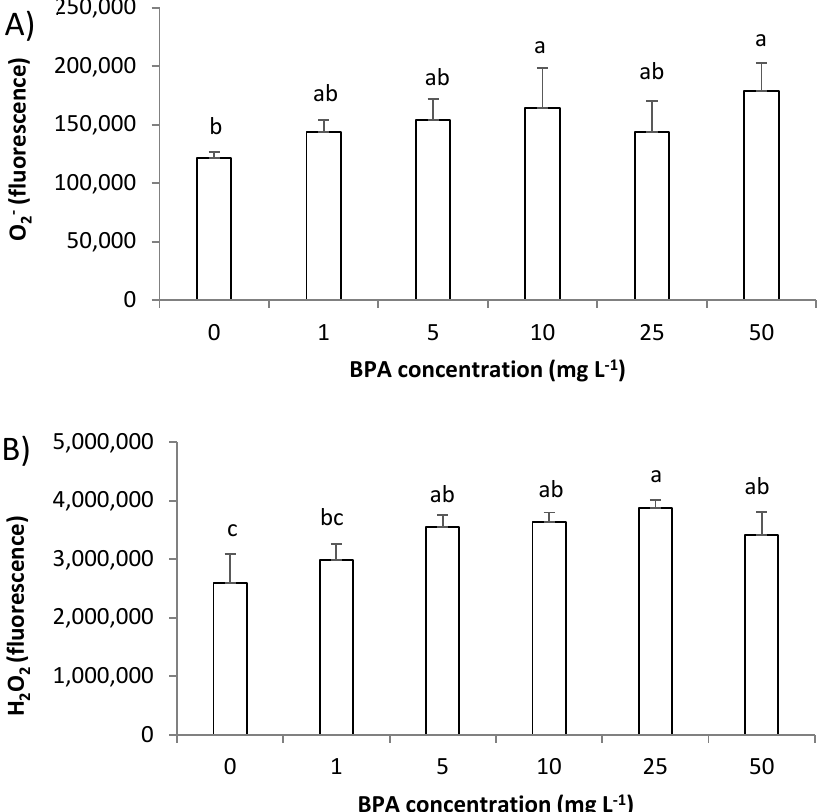
Figure 4. Level of reactive oxygen species (ROS) in root cells of Allium cepa exposed to bisphenol A (BPA) in concentration range 1–50 mg L − 1 for 3 days. Level of: ( A ) superoxide radical (O 2 − ) and ( B ) hydrogen peroxide (H 2 O 2 ). Results are presented as means ± SD (n = 5 replicates). Different letters indicate significant difference ( p ≤ 0.05). 0—control plants, not exposed to BPA.